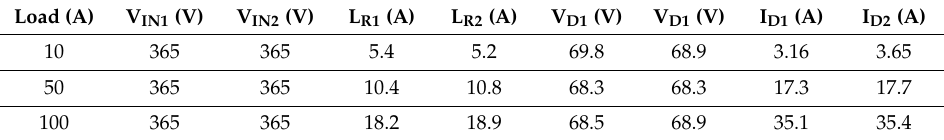
Table 4. Balance characteristics of the proposed converter at each load.